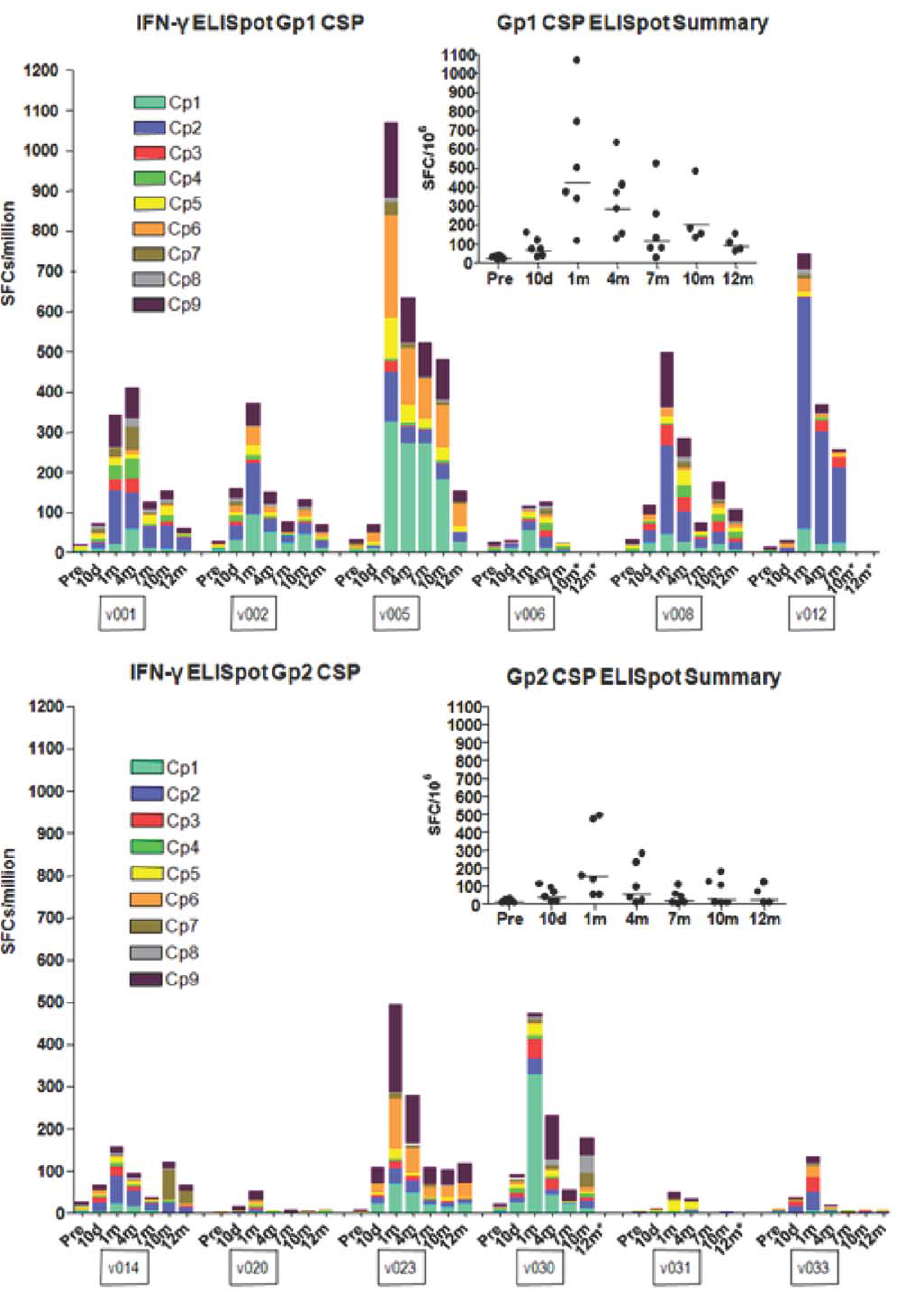
Figure 4. ELISpot activity of serial bleeds of volunteers in Group 1 and Group 2 with CSP peptide pools. The ELISpot activities of each volunteer at pre-immunization, 10 d and 1, 4, 7, 10 and 11–12 m are displayed using color-coded CSP peptide pools Cp1–Cp9. The inserts show the values of the sum of each volunteer’s responses at each time point and the bar indicates the geometric mean of the group. At 1 month, geomean values were higher (422 sfc/m PBMC’s) in the low dose Group 1 than the high dose Group 2 (154 sfc/m PBMC’s).